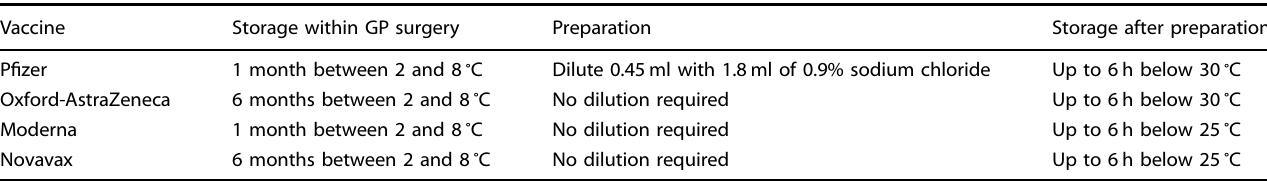
Table 1. Storage and preparation requirements for the four most common Covid-19 vaccines. Data taken from ref. 26 .